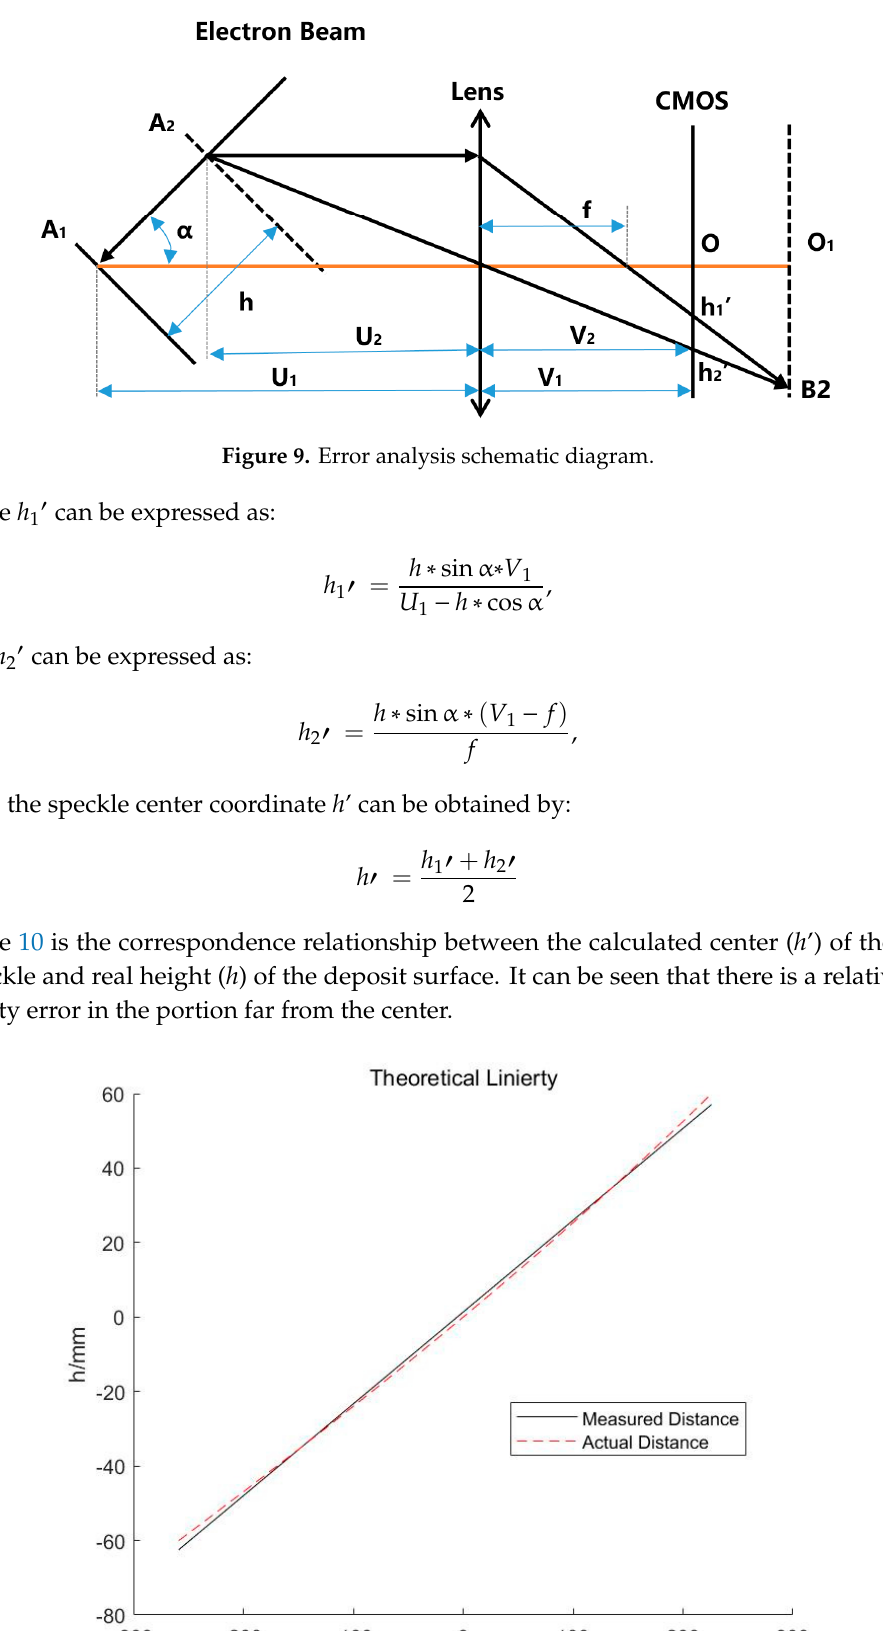
Figure 11. Theoretical errors of the measurement system.